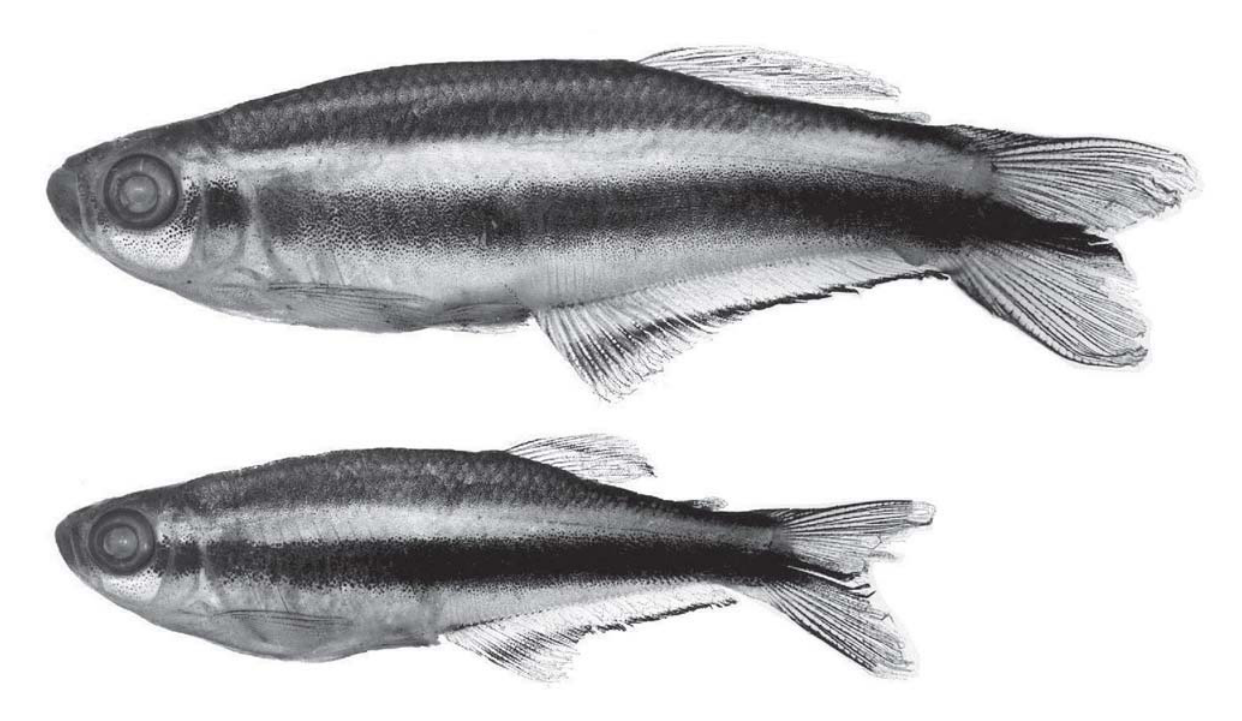
Fig. 36. Mimagoniates barberi , male above, UMMZ 205420, 35.6 mm SL, female below, SL 26.8 mm, Paraguay, San Pedro, rio Aguarai-mi, tributary to rio Paraguay,